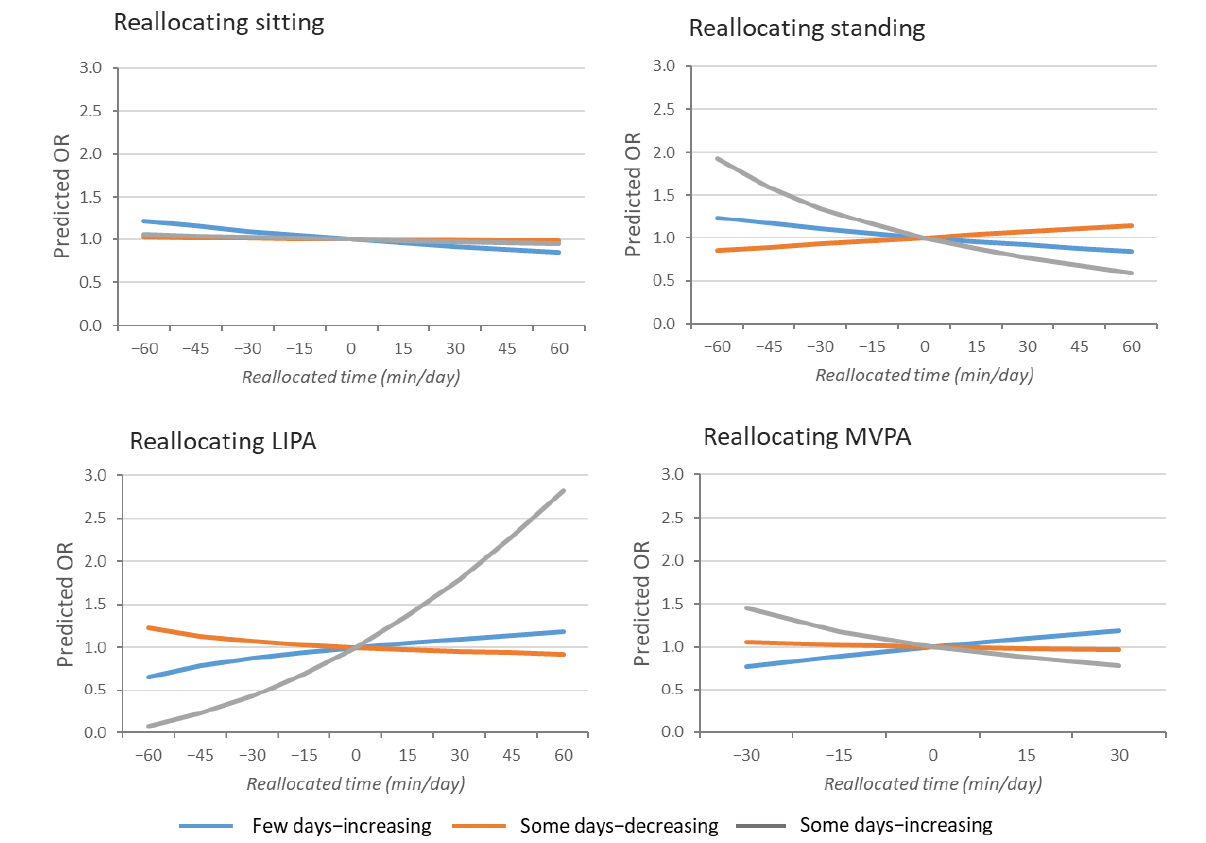
Figure 2. Predicted odds ratios (ORs) of sick leave trajectories when reallocating time in each behavior at work (sitting, standing, LIPA, and MVPA) to all other behaviors. The trajectory with no sick leave was used as reference.